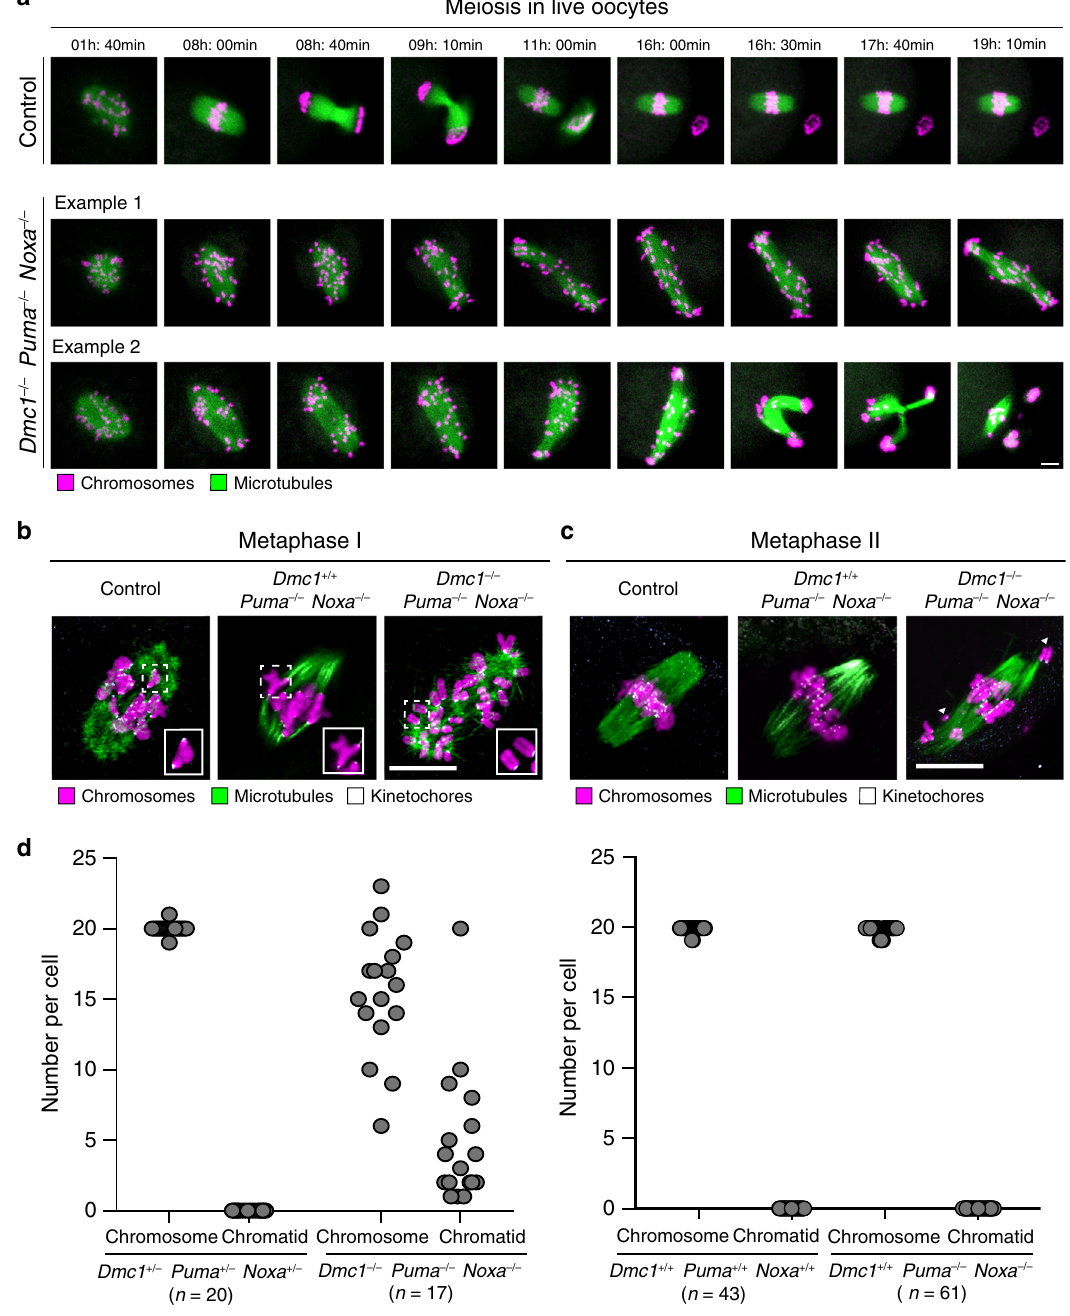
Fig. 3 Dmc1 − / − Puma − / − Noxa − / − oocytes resume meiosis. a Different stages of meiosis determined from live imaging in control ( N = 3 experimental repetitions; n = 7 females; n = 39 oocytes) and Dmc1 − / − Puma − / − Noxa − / − oocytes ( N = 3 experimental repetitions; n = 7 females; n = 60 oocytes) expressing green fl uorescent protein – microtubule-associated protein 4 (mEGFP – MAP4; green), and histone 2B – monomeric red fl uorescent protein 1 (H2B – mRFP1; magenta). Images show z -projections of 21 sections, every 3 μ m. Scale bar, 10 µ m. Time displayed in hours:minutes. b , c Representative images of chromosomes (Hoechst, magenta), kinetochores (CREST, white), and microtubules ( α -tubulin, green) in metaphase I and metaphase II ( z -projections every 0.19 μ m) cold-treated oocytes from control ( Dmc1 + / − Puma + / − Noxa + / − or Dmc + / + Puma + / + Noxa + / + ; n = 10 females), Dmc1 + / + Puma − / − Noxa − / − ( n = 8 females) and Dmc1 − / − Puma − / − Noxa − / − ( n = 2 females). Insets show a magni fi cation of a meiosis I bivalent chromosome (left and middle) or two prematurely dissociated univalent chromosomes (right). All oocytes preserved at metaphase I had all 20 chromosomes in either the bivalent or in the univalent morphology. Scale bar, 10 µ m. d Graph representing the number of chromosomes and chromatids per metaphase II oocyte (left graph: N = 2 experimental repetitions; n = 2 control Dmc1 + / − Puma + / − Noxa + / − females, n = 20 oocytes; n = 2 Dmc1 − / − Puma − / − Noxa − / − females, n = 17 oocytes; right graph: N = 2 experimental repetitions; n = 8 control Dmc + / + Puma + / + Noxa + / + females, n = 43 oocytes; n = 8 Dmc + / + Puma − / − Noxa − / − females, n = 61